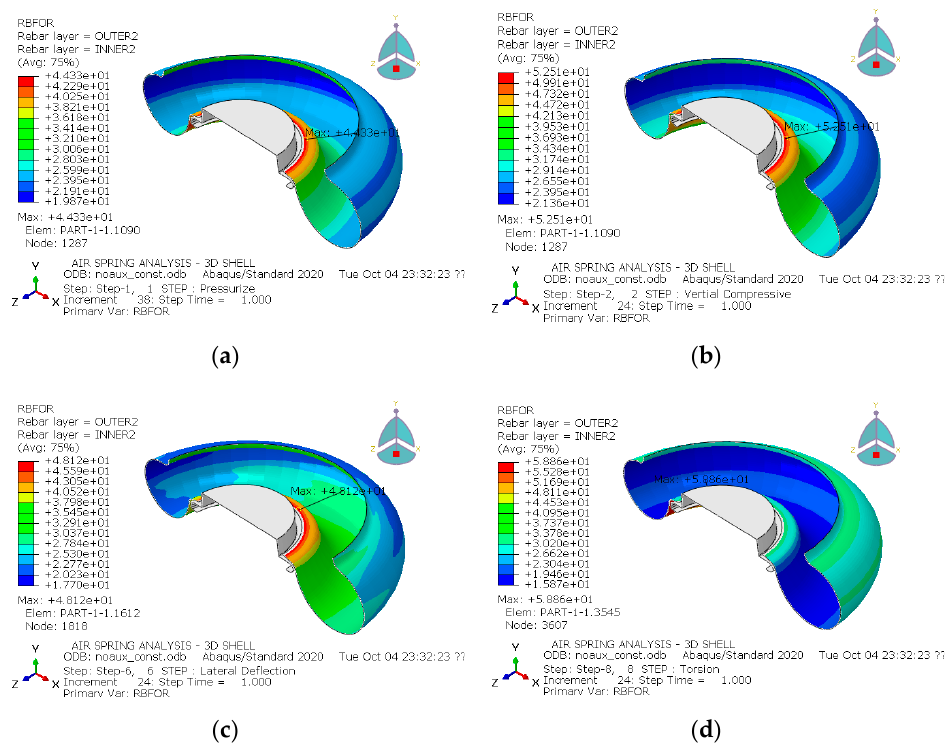
Figure 13. Distribution of rebar force (RBFOR) during analysis at constant ply angle distributions: ( a ) inflation; ( b ) vertical compression; ( c ) lateral deflection; ( d ) torsional rotation.